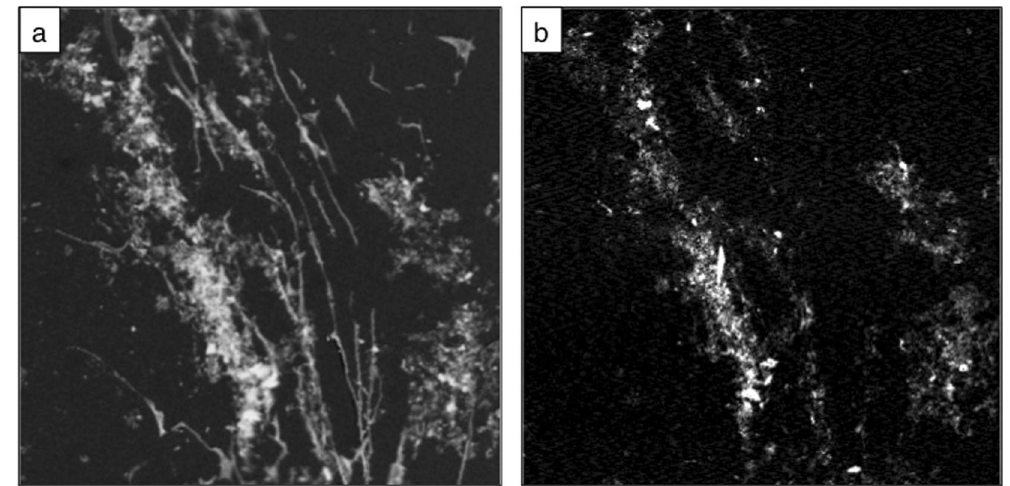
Figure 2. STXM “Scan Maps” collected between ( a ) 280 and 288.6 eV for carbon, and ( b ) between 700 and 710 eV for iron, respectively. These maps allowed selecting areas where OC and Fe were co-localized in our samples for NEXAFS